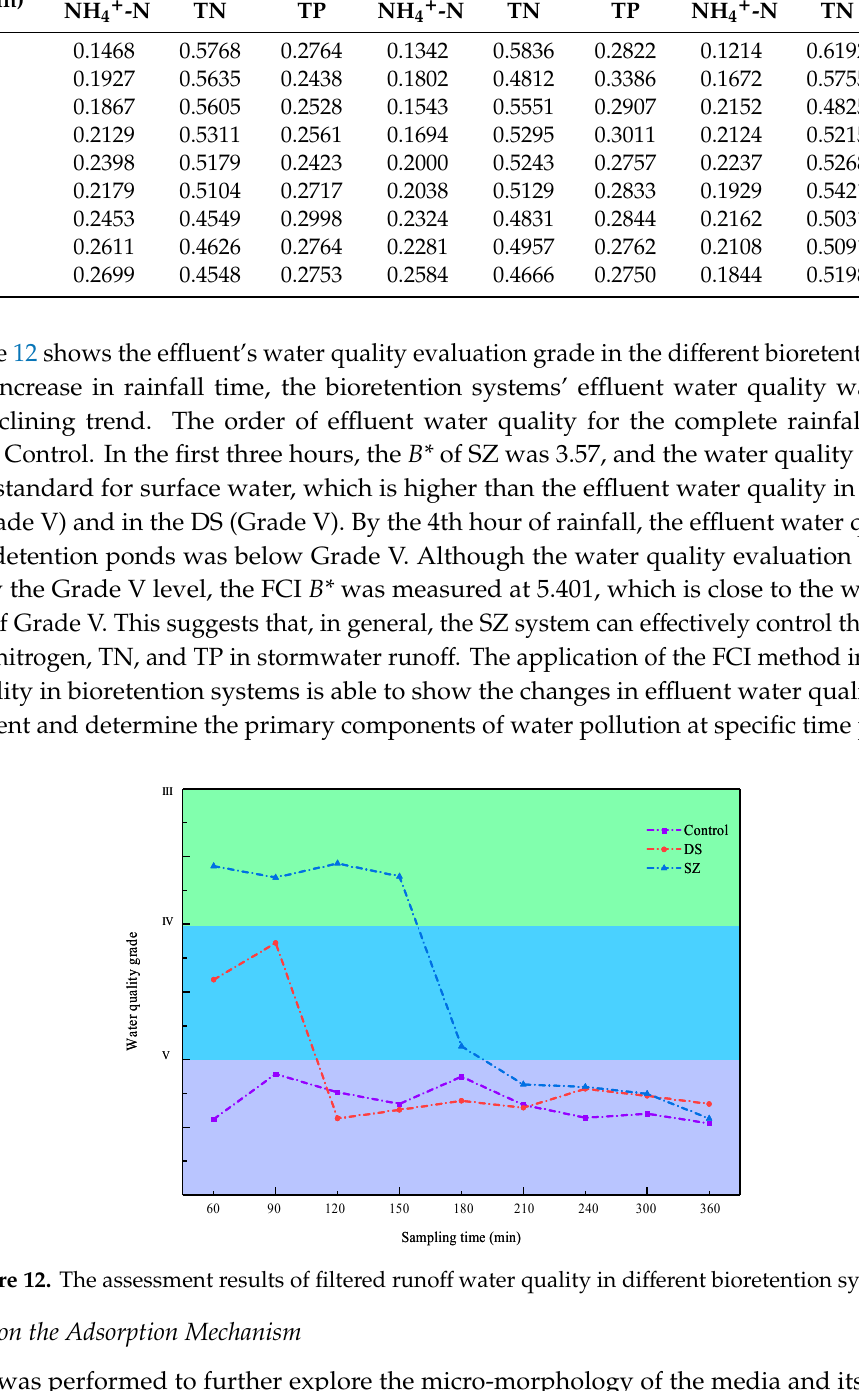
Table 5. The weights of the pollution factors in water samples.